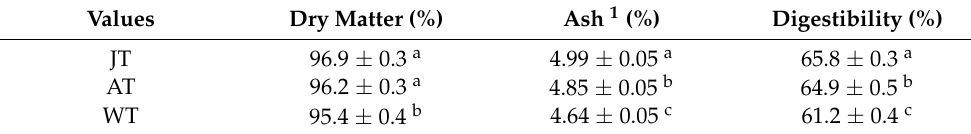
Table 1. Dry matter and ash contents and in vitro digestibility values of matcha teas.